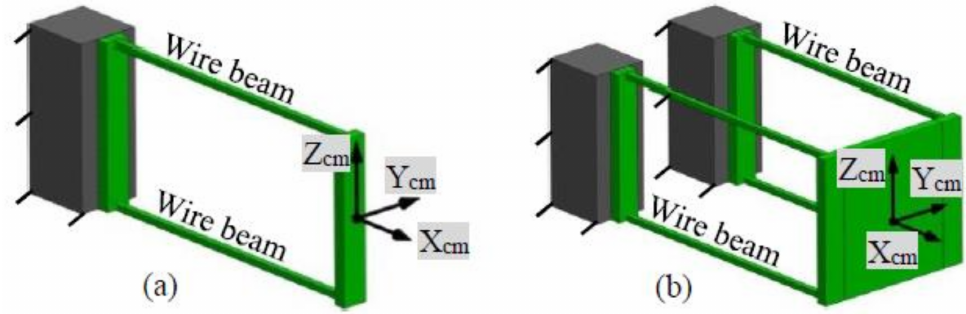
Figure 4. Compliant modules: ( a ) A two-beam compliant module (TBCM) and its coordinate system and ( b ) a four-beam compliant module and its coordinate